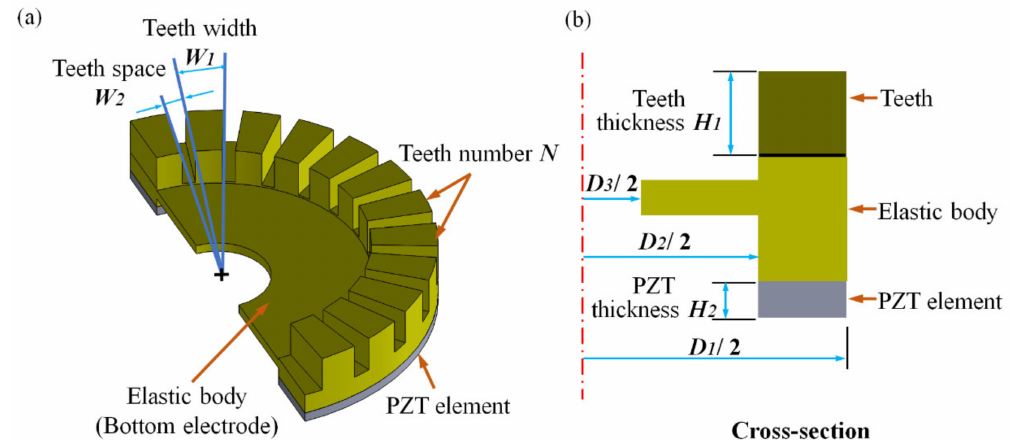
Figure 1. ( a ) PZT thick film micro vibrator structure and ( b ) cross-section of the micro piezoelectric vibrator.